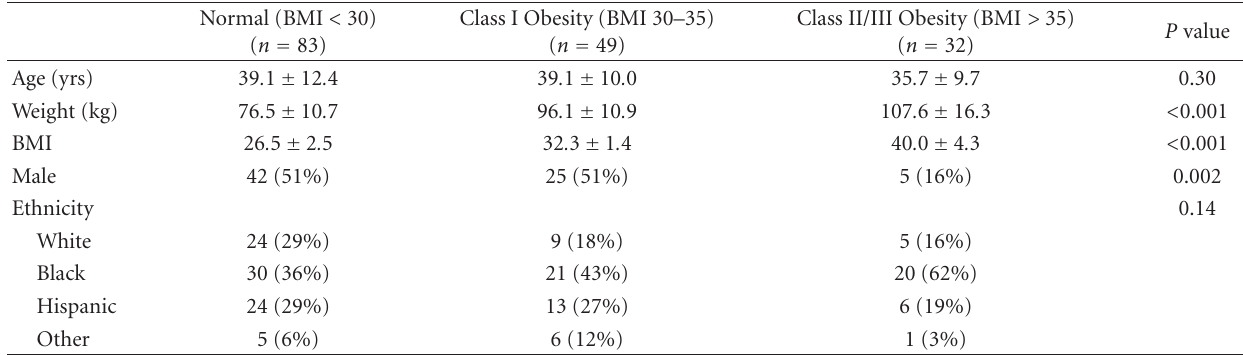
Table 1: Characteristics of potential kidney donors with measured glomerular filtration rate.